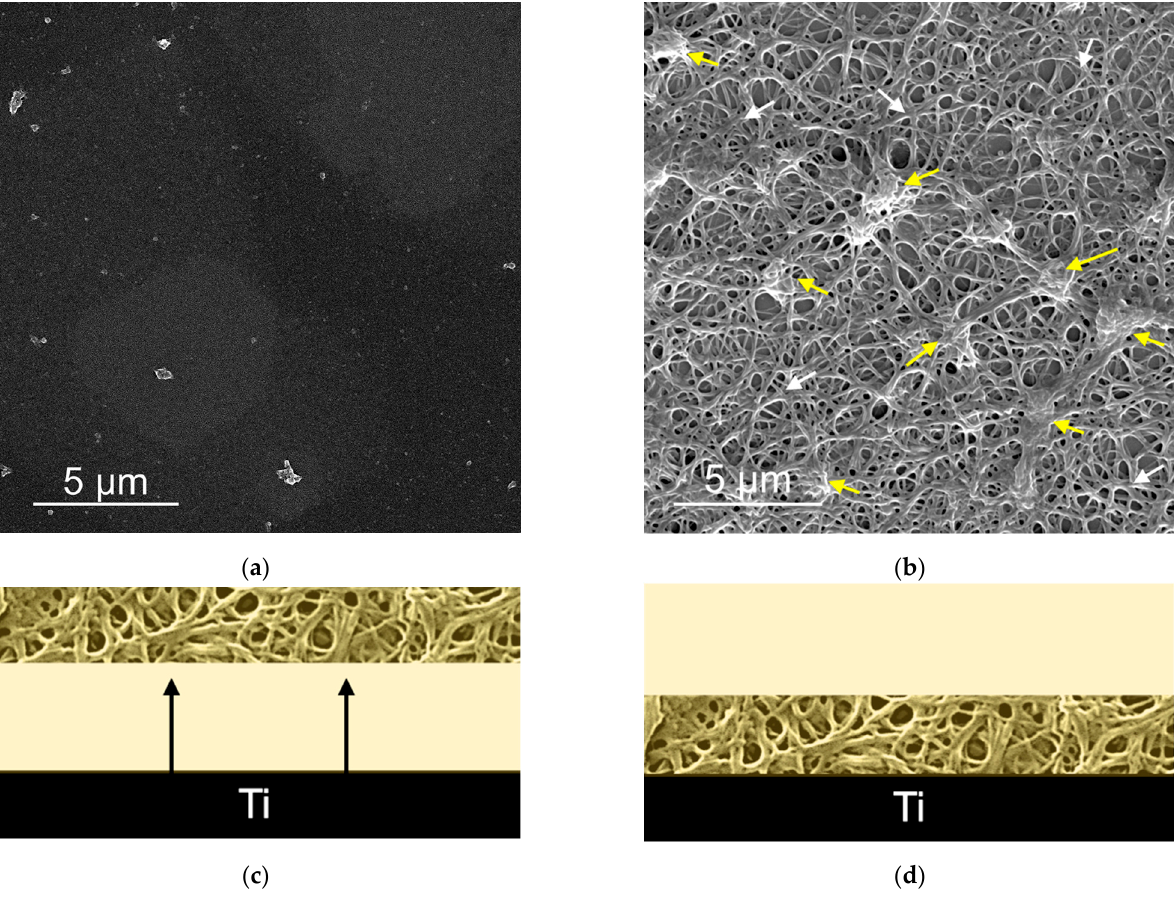
Figure 4. Scanning Electron Micrographs of the QCM sensor surfaces after the QCM experiments. ( a ) NoCa surfaces showed no adsorbed material. ( b ) Ca surfaces had a fibrin film (white arrows) with embedded platelets and platelet aggregates (yellow arrows). Below each micrograph, a scheme illustrating the phenomena at ( c ) NoCa and ( d ) Ca is proposed. The black arrows in ( c ) indicate detachment of the clot from the surface. At ( d ), the clot remains attached to the surface.